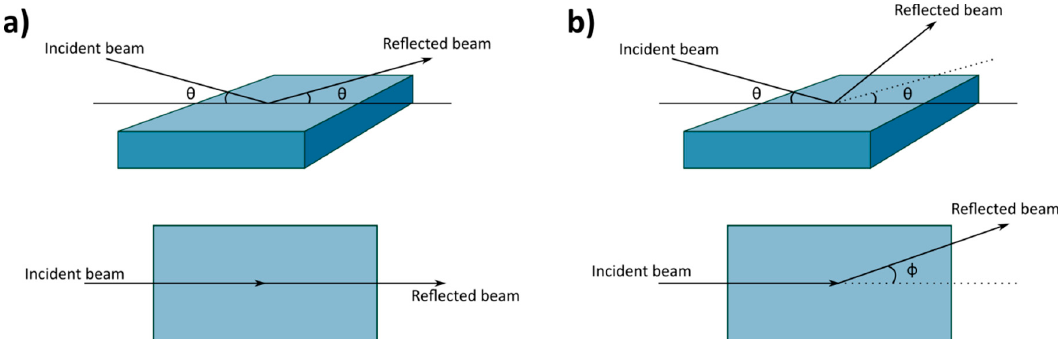
Figure 1. Illustration of the geometry of a neutron reflectometry experiment: ( a ) specular reflection and ( b ) off-specular reflection (top: isometric view; bottom: plan view).